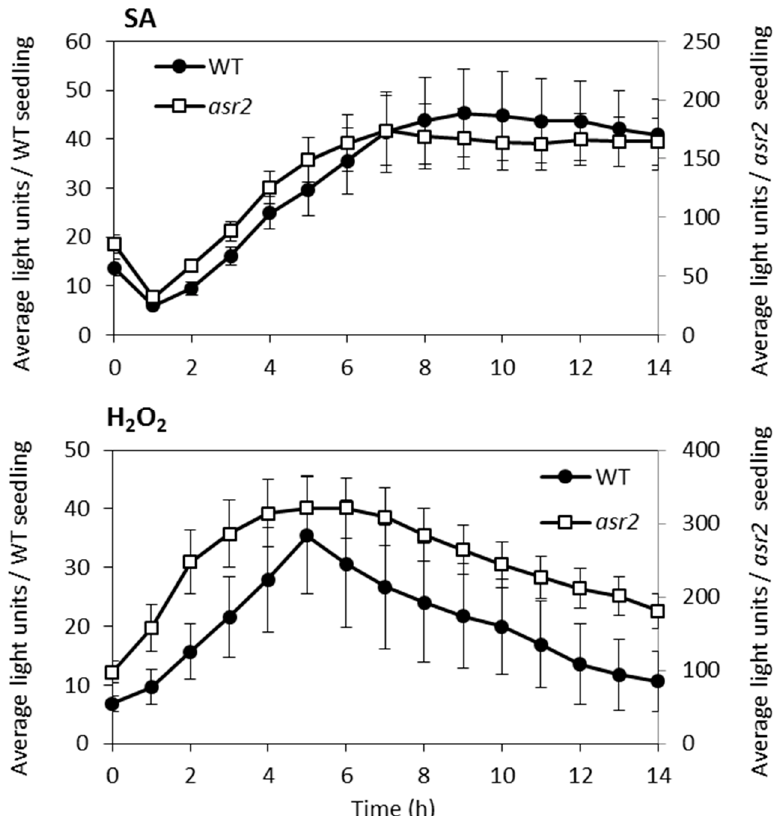
Figure 2. GSTF8:LUC response in asr2 is maintained following salicylic acid (SA) or H 2 O 2 induction. Average GSTF8:LUC expression per wild-type (WT) and asr2 seedling per hour after treatment with 1 mM salicylic acid (SA) (upper panel) or 1 mM H 2 O 2 (lower panel). Values are averages ± SE ( n = 10) from four-day-old seedlings. WT values are plotted on the primary (left) axis and asr2 values on the secondary (right) axis.